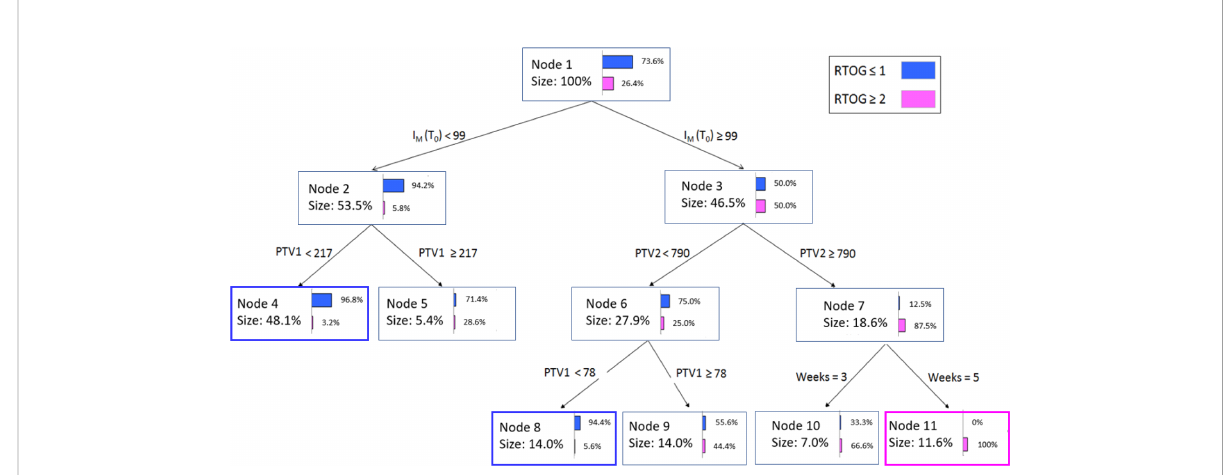
FIGURE 5 Classi fi cation and Regression tree analysis (CART) for the most signi fi cant